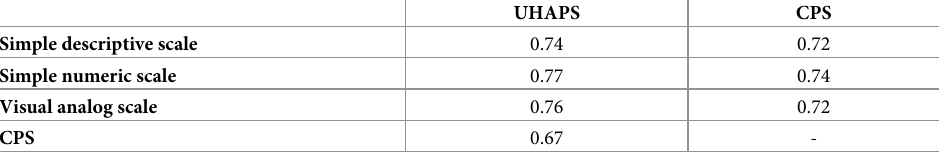
Table 6. Criterion validity based on the correlation between the Unesp-Botucatu horse acute pain scale (UHAPS) and the Composite Pain Scale (CPS) vs unidimensional scales to assess perioperative